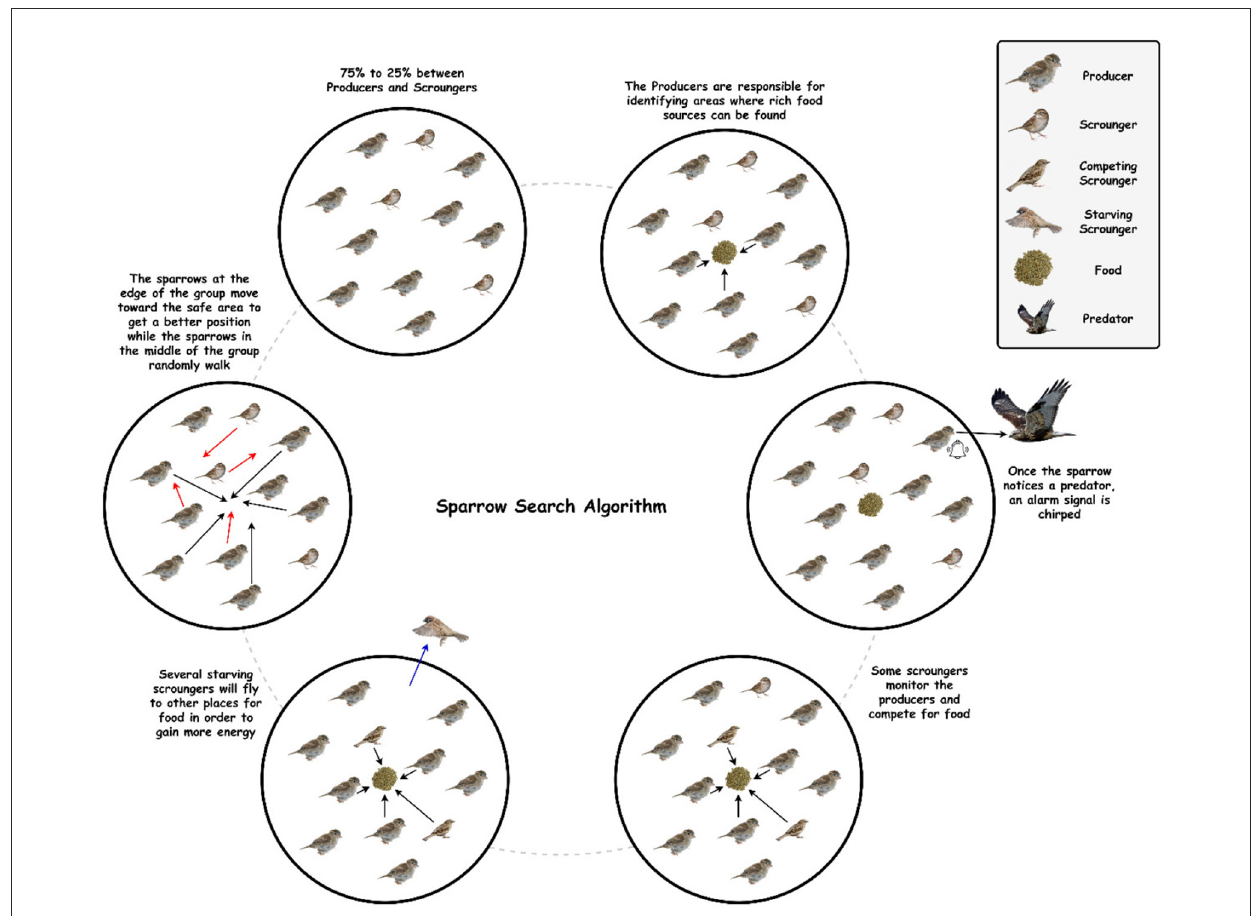
FIGURE2 The schematic diagram of sparrow